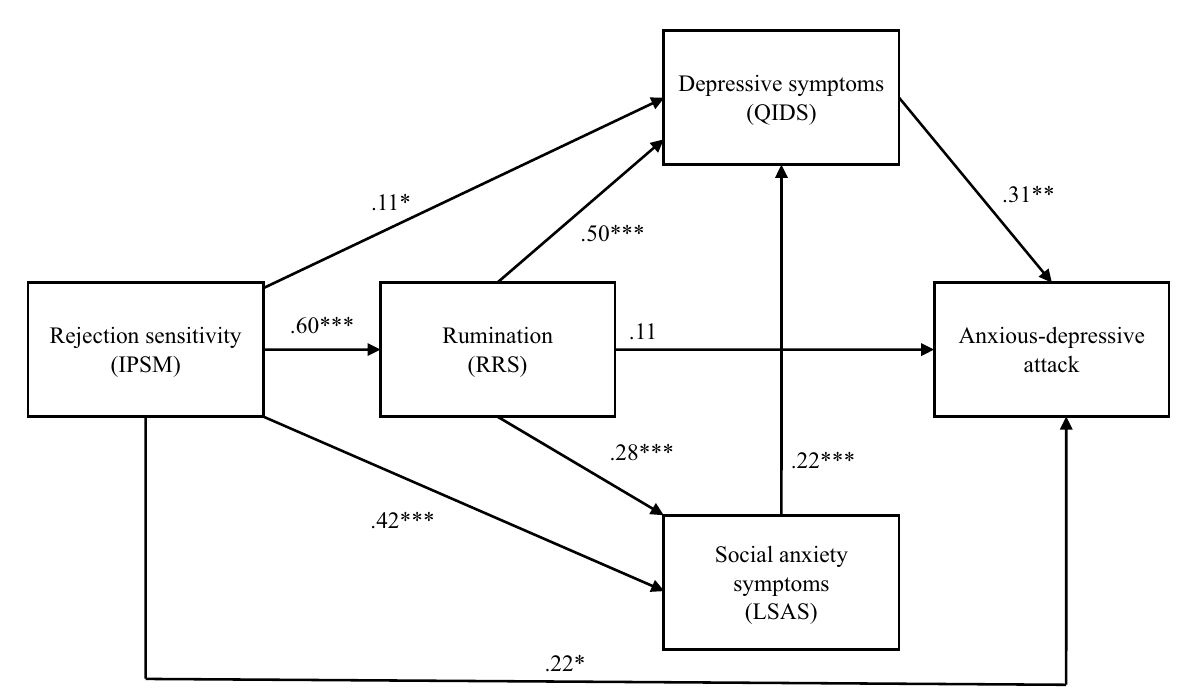
FIGURE 1 The structural equation model, showing the relationships among rejection sensitivity, rumination, social anxiety symptoms, depressive symptoms, and anxious-depressive symptoms. Chi-square value: χ 2 = 0.10, df = 1, p = 0.76; comparative fit index = 1.000; Tucker–Lewis Index = 1.000; root mean square error of approximation = 0.000, 90% confidence interval = 0.000–0.099; and standardized root mean square residual = 0.004. IPSM, Interpersonal Sensitivity Measure; RRS, Ruminative Responses Scale; LSAS, Liebowitz Social Anxiety Scale; QIDS, Quick Inventory of Depressive Symptomatology. * p < 0.05; ** p < 0.01; *** p <